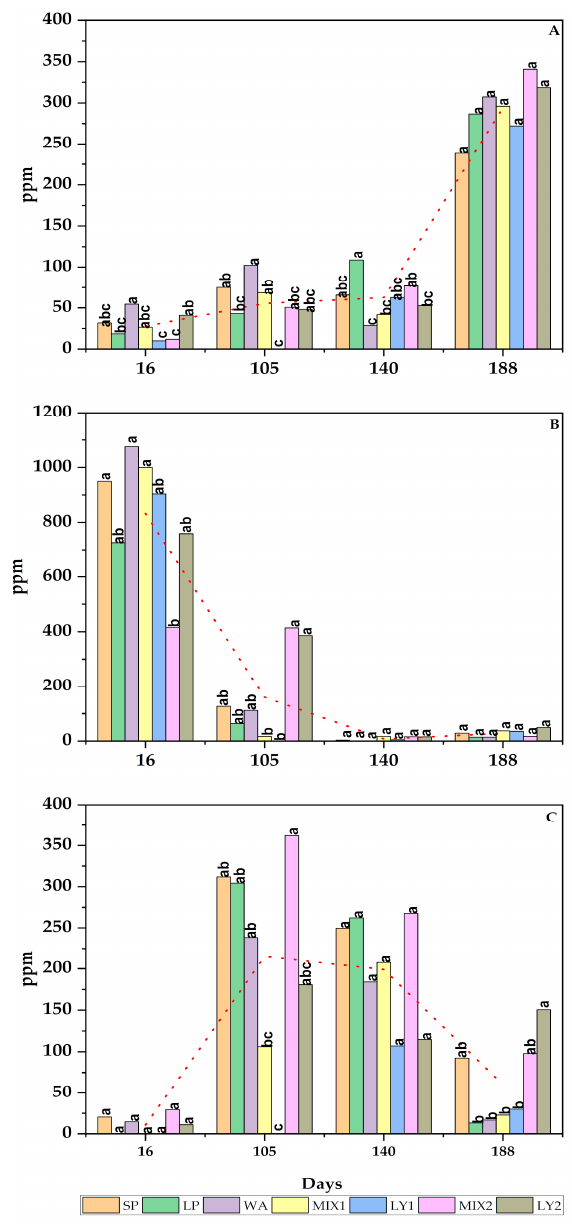
Figure 4. Citric acid ( A ), malic acid ( B ) and succinic acid ( C ) in the brines. The data are expressed as averages of the triplicate measurements. Significant differences (LSD) are indicated by different letters ( p ≤ 0.05). Red dotted line represents the average values at each sampling time.